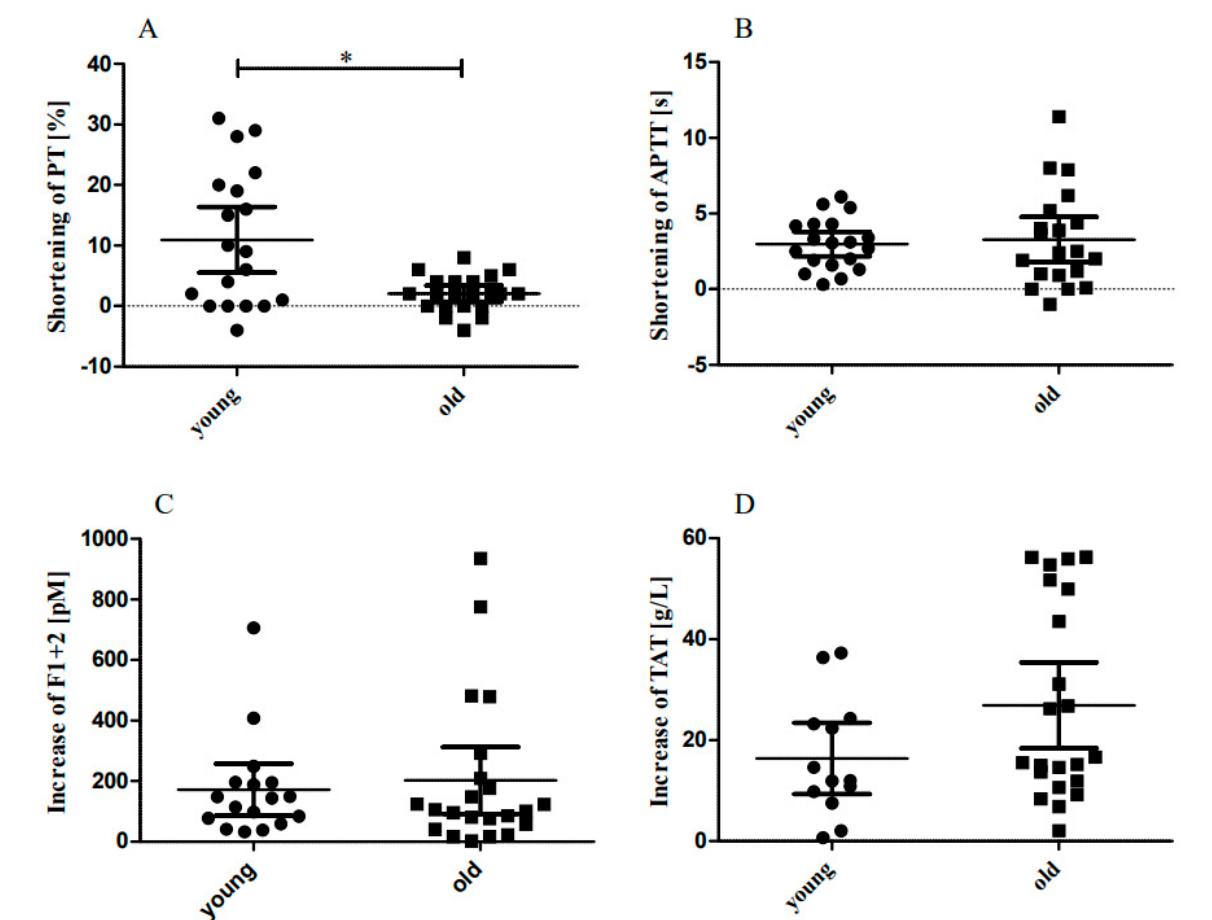
Figure 1. Coagulation activation due to orthostatic challenge. The sit-to-stand test caused coagulation activation in both young and older participants. Panel ( A ): the shortening of prothrombin times (PT) was significantly higher in young compared with older participants ( p = 0.0242). Panel ( B ): the shortening of activated partial thromboplastin times (APTTs) was similar in young and older partic- ipants. Panel ( C ): the increases of Prothrombin fragment 1 + 2 (F1 + 2) were similar in young and older participants. Panel ( D ): the increases in Thrombin/antithrombin complexes (TAT) were similar in young and older participants. * p <